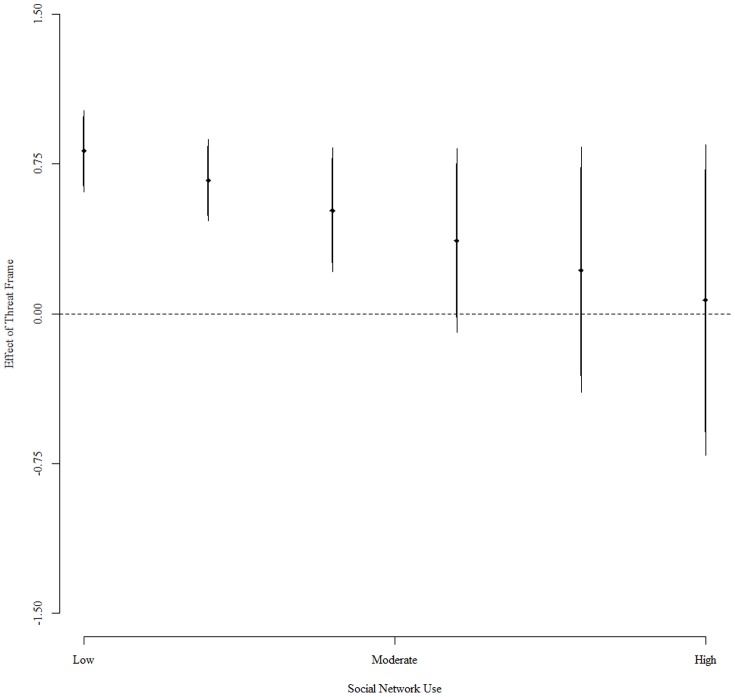
This figure displays the effect of the threat treatment for different levels of social network use (positive values indicate greater support for security policies).Each point estimate (represented by a diamond) shows the predicted change in an individual's level of support for government monitoring of the internet. Around each point estimate there are two lines. The heavier shaded line represents a 90% confidence interval, while the lighter shaded line represents a 95% confidence interval. The figure illustrates that the effect of the security treatment diminishes as social network website use increases. This supports the hypothesis that increased social network website use leads to more resistance to security-based rationales for increasing governmental monitoring.